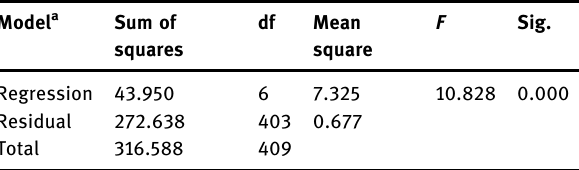
Table 12: ANOVA for model one ( dependent variable: healthy